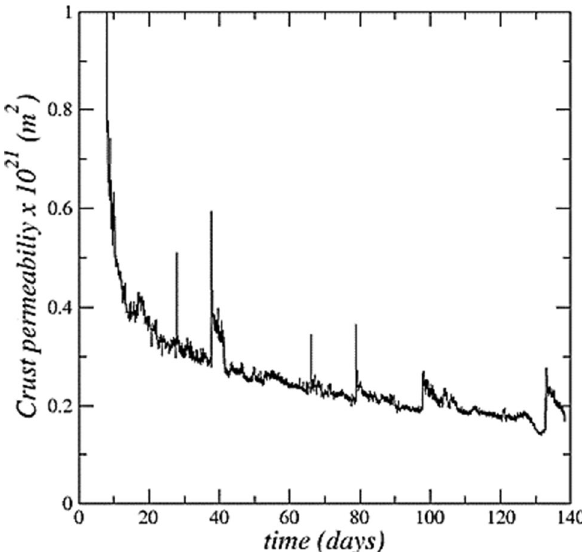
Figure 8. Detached crust permeability estimate as a function of